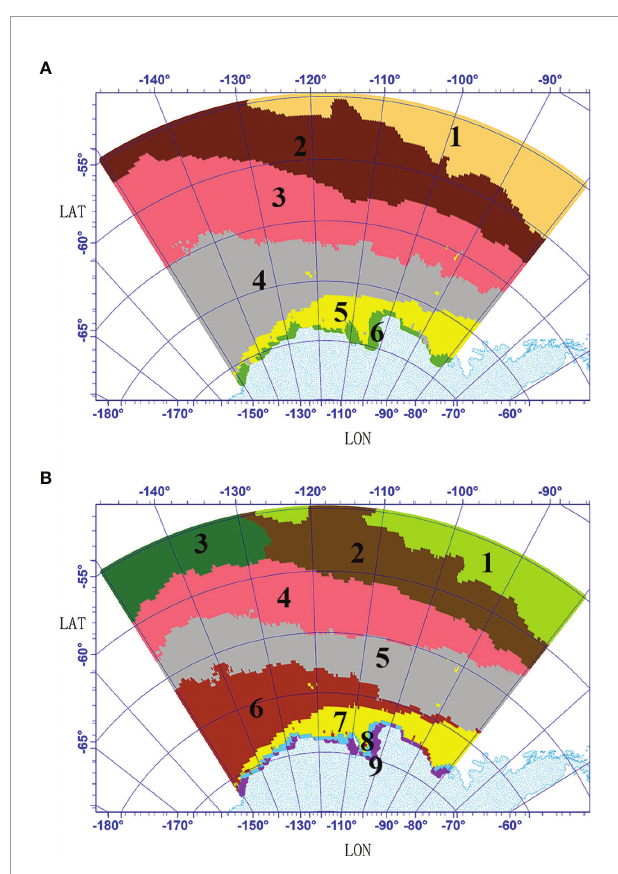
FIGURE 4 | Six bioregions (A) and nine subregions (B) identi fi ed in the K - means cluster